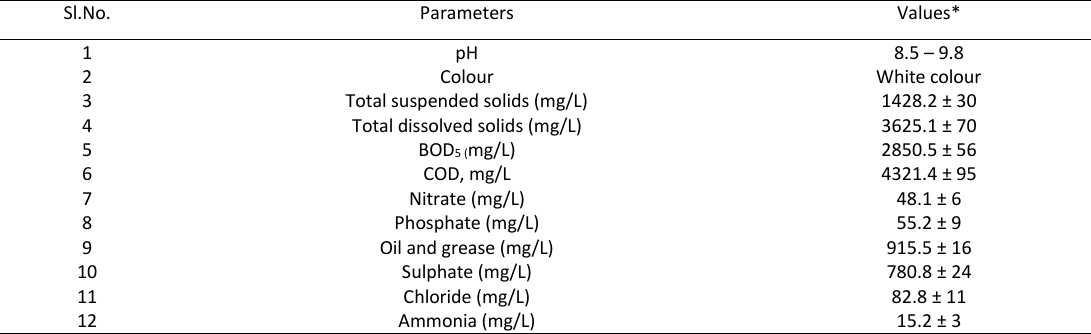
Table 1: The Characteristics of Dairy Industry Wastewater Sl.No.